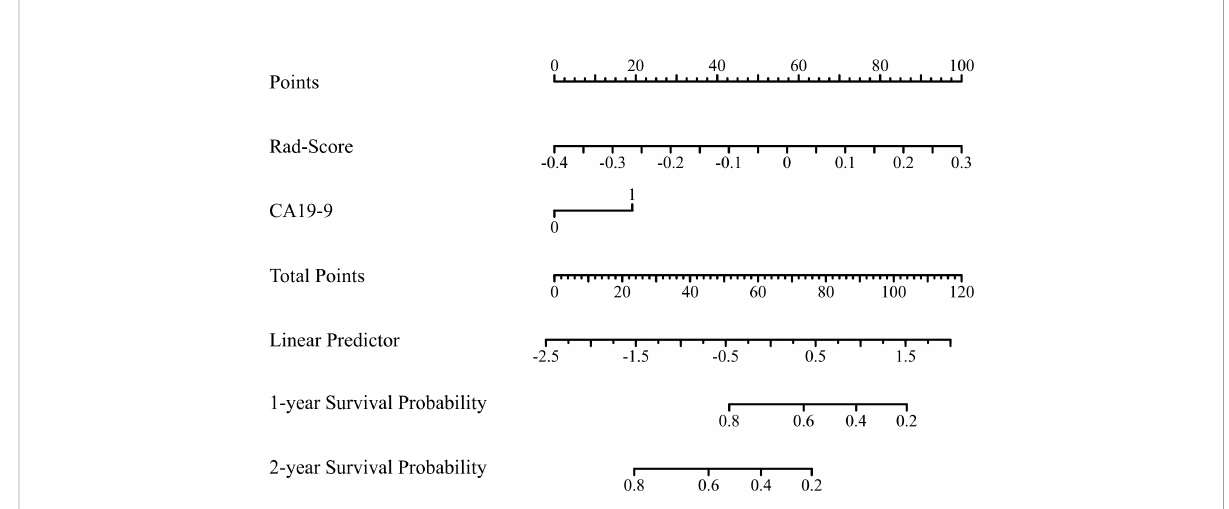
FIGURE 6 The predictive nomogram based on radiomic nomogram Rad-score and CA199